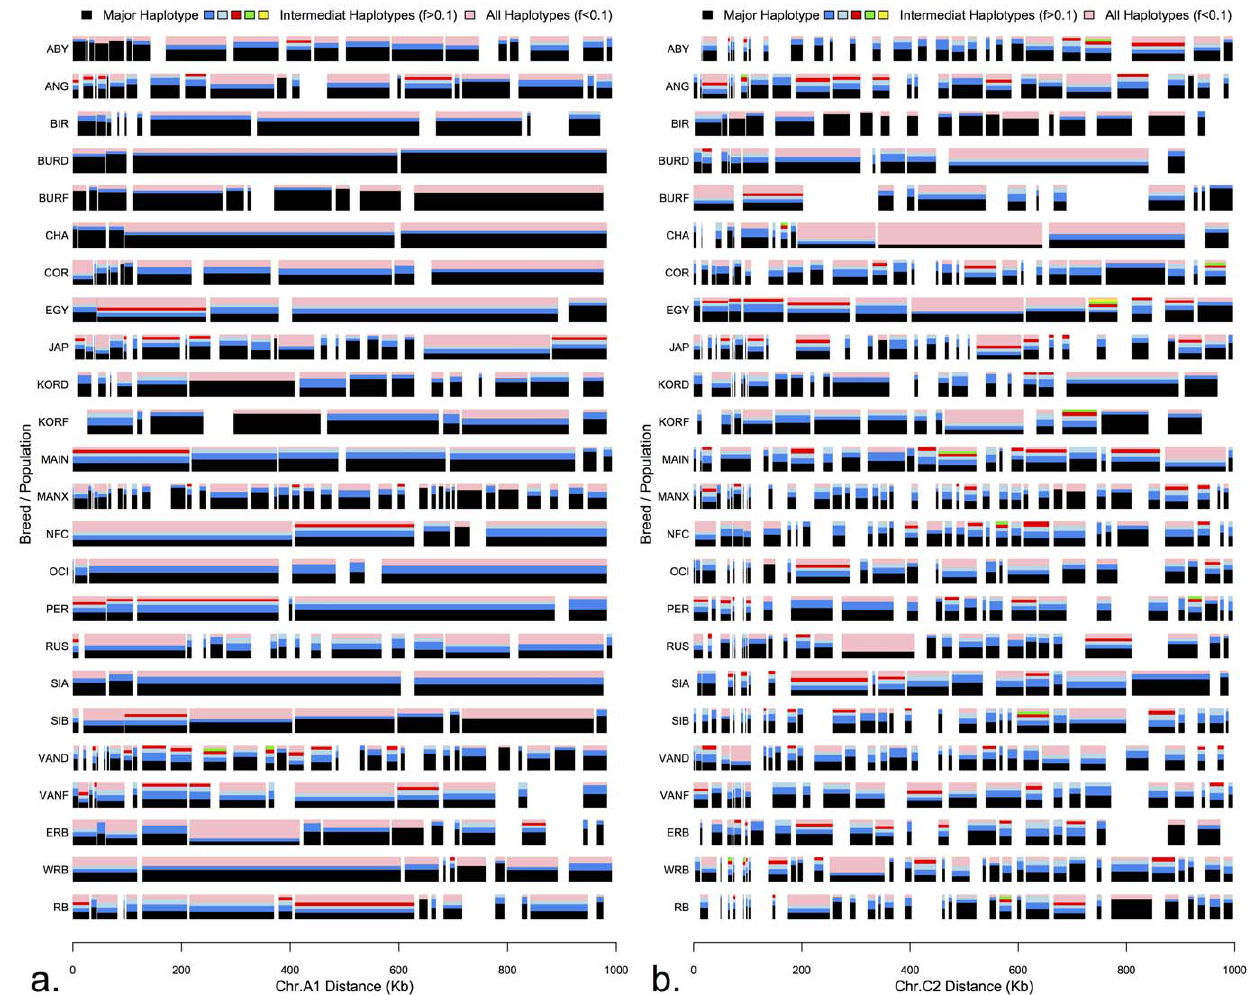
Figure 5. Domestic cat haplotype structure and diversity of two autosomal regions. a) Haplotype analysis of chromosome A1 region, which exhibits long extent of LD. b) Haplotype analysis of chromosome C2 region, which exhibits short extent of LD. Breeds/populations are represented on the y-axis and the position of haplotype blocks are shown on the x axis. Haplotype blocks are represented by horizontal rectangles. The frequency of individual haplotypes within a block is proportional to the height of the color. Major haplotype is represented by black color, intermediate haplotypes with frequency . 0.1 are represented by blue, light blue, red, green and yellow, respectively. Pink color represents the sum of the frequencies of all haploypes with a frequency , 0.1. Empty regions between blocks indicate lack any informative markers (MAF $ 0.05) and can be considered monomorphic across all individuals within a population.